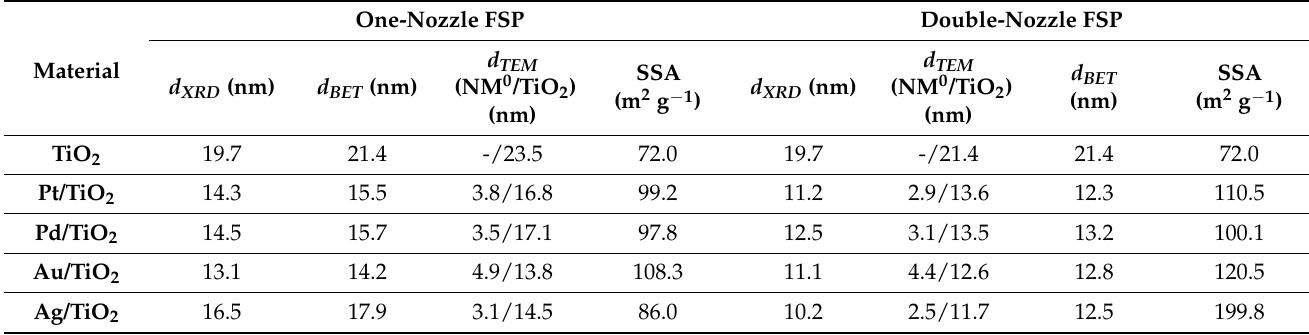
Table 1. pXRD size, d BET , d TEM and SSA (specific surface area) of the produced materials.